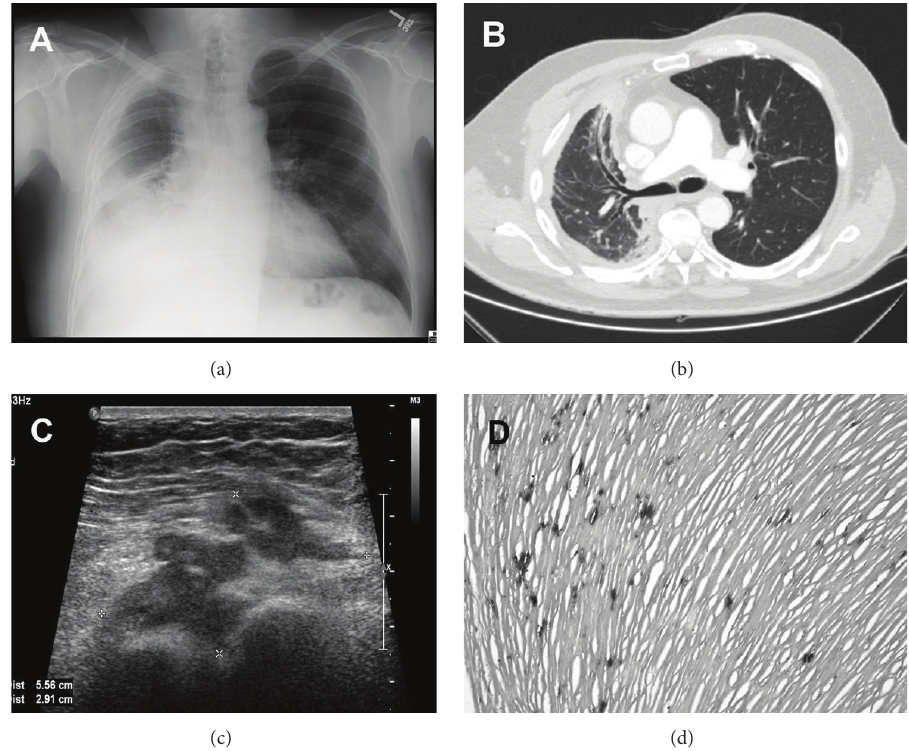
Figure 1: (a) Anteroposterior chest X-ray shows pleural thickening along the right lateral chest wall and blunting of the right costophrenic angle. (b) A chest CT scan shows extensive pleural thickening on the right side and calcified pleural plaque on the left side. (c) A breast ultrasound shows an irregular, hypoechoic mass measuring 5.6 × 2.9 × 3.6 cm. A portion of the mass involves pectoralis muscle and extends into the intercostal muscles. (d) Pleural biopsy shows plaque formation with dense fibrosis, minimal inflammation, and dystrophic calcification with no evidence of